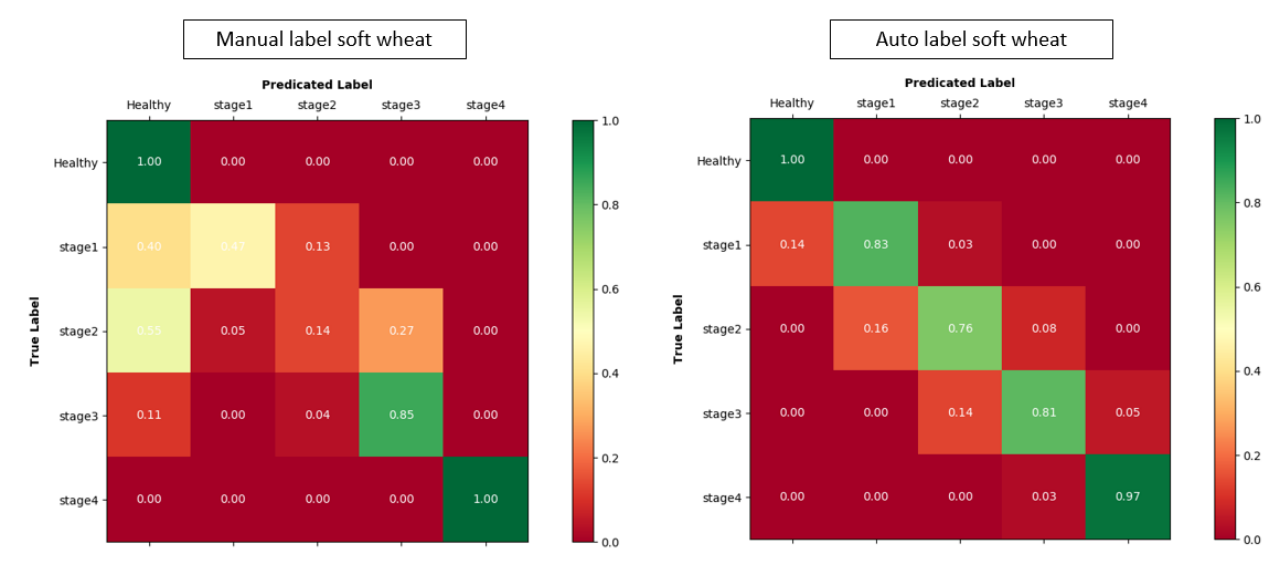
Figure 5. Comparison of the confusion matrices showing the result of the manually labelled and automatically labelled disease detection models for rust disease on soft wheat. The values shown are normalised, showing the percentage of the true label that was classified as each of the five classes. Note that classes were renamed to healthy, stage 1, stage 2, stage 3, and stage 4 instead of numbers 1 to 5 to indicate that label 1 corresponded with the healthiest pixels, whereas label 5 corresponded with the most advanced disease stage.